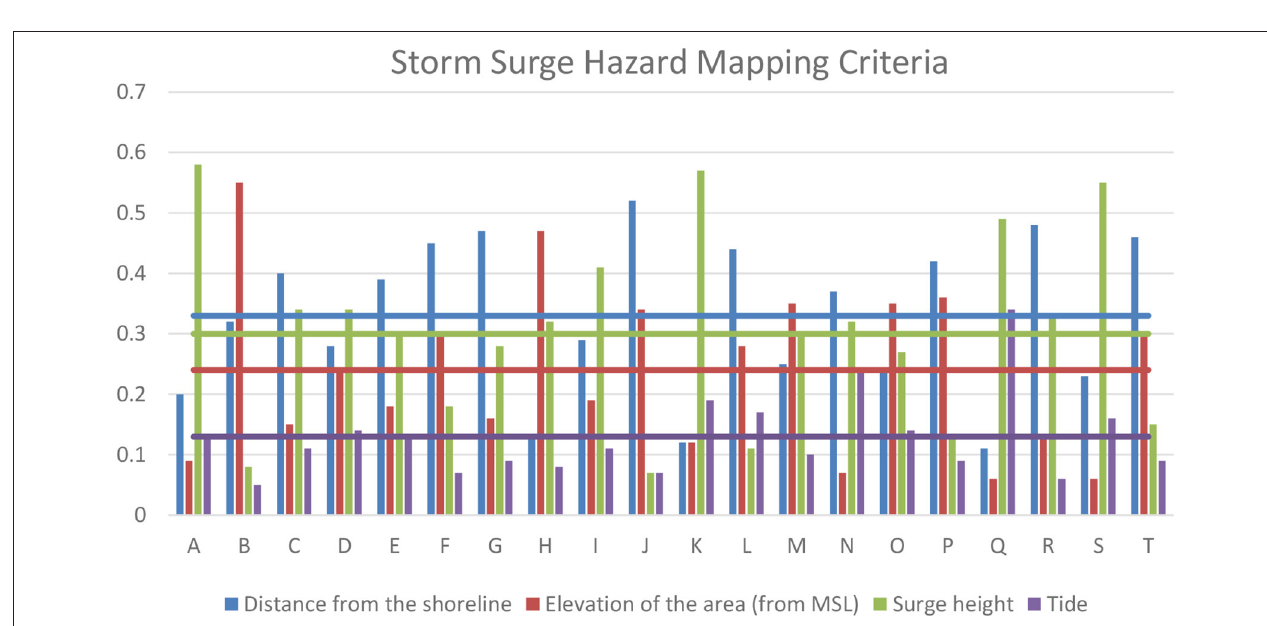
FIGURE 6 | Weights of the criteria for storm surge hazard mapping using AHP showing the mean values in horizontal lines.